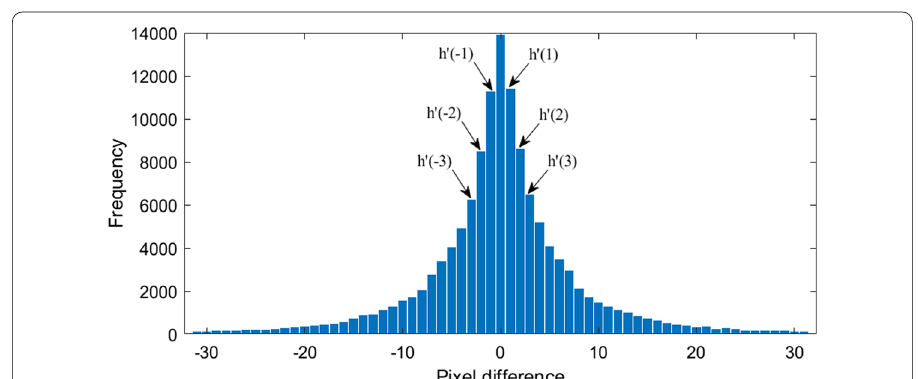
Fig. 4 PDH using PVD steganography with an embedding ratio of 10% (type 1 of the PVD